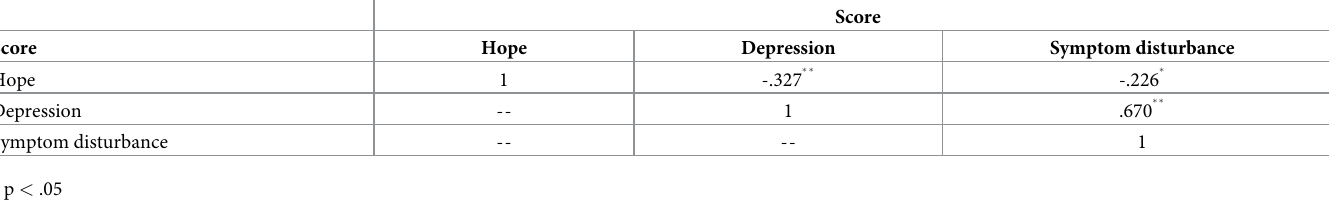
Table 2. Correlations of hope, depression, and symptom disturbance among